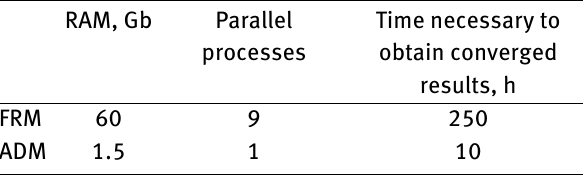
Table 2: Computational effort of the FRM and ADM simulations. RAM, Gb Parallel Time necessary to processes obtain converged results, h FRM 60 9 250 ADM 1.5